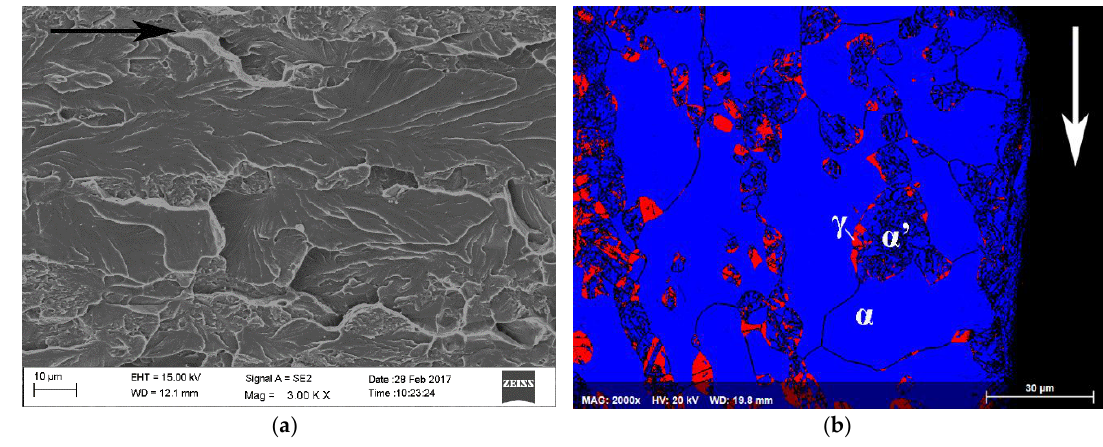
Figure 4. Fracture surface ( a ) and EBSD phase map ( b ) of the delayed crack in the cup of steel C at DR 2.0. The direction of crack propagation is marked with arrows.